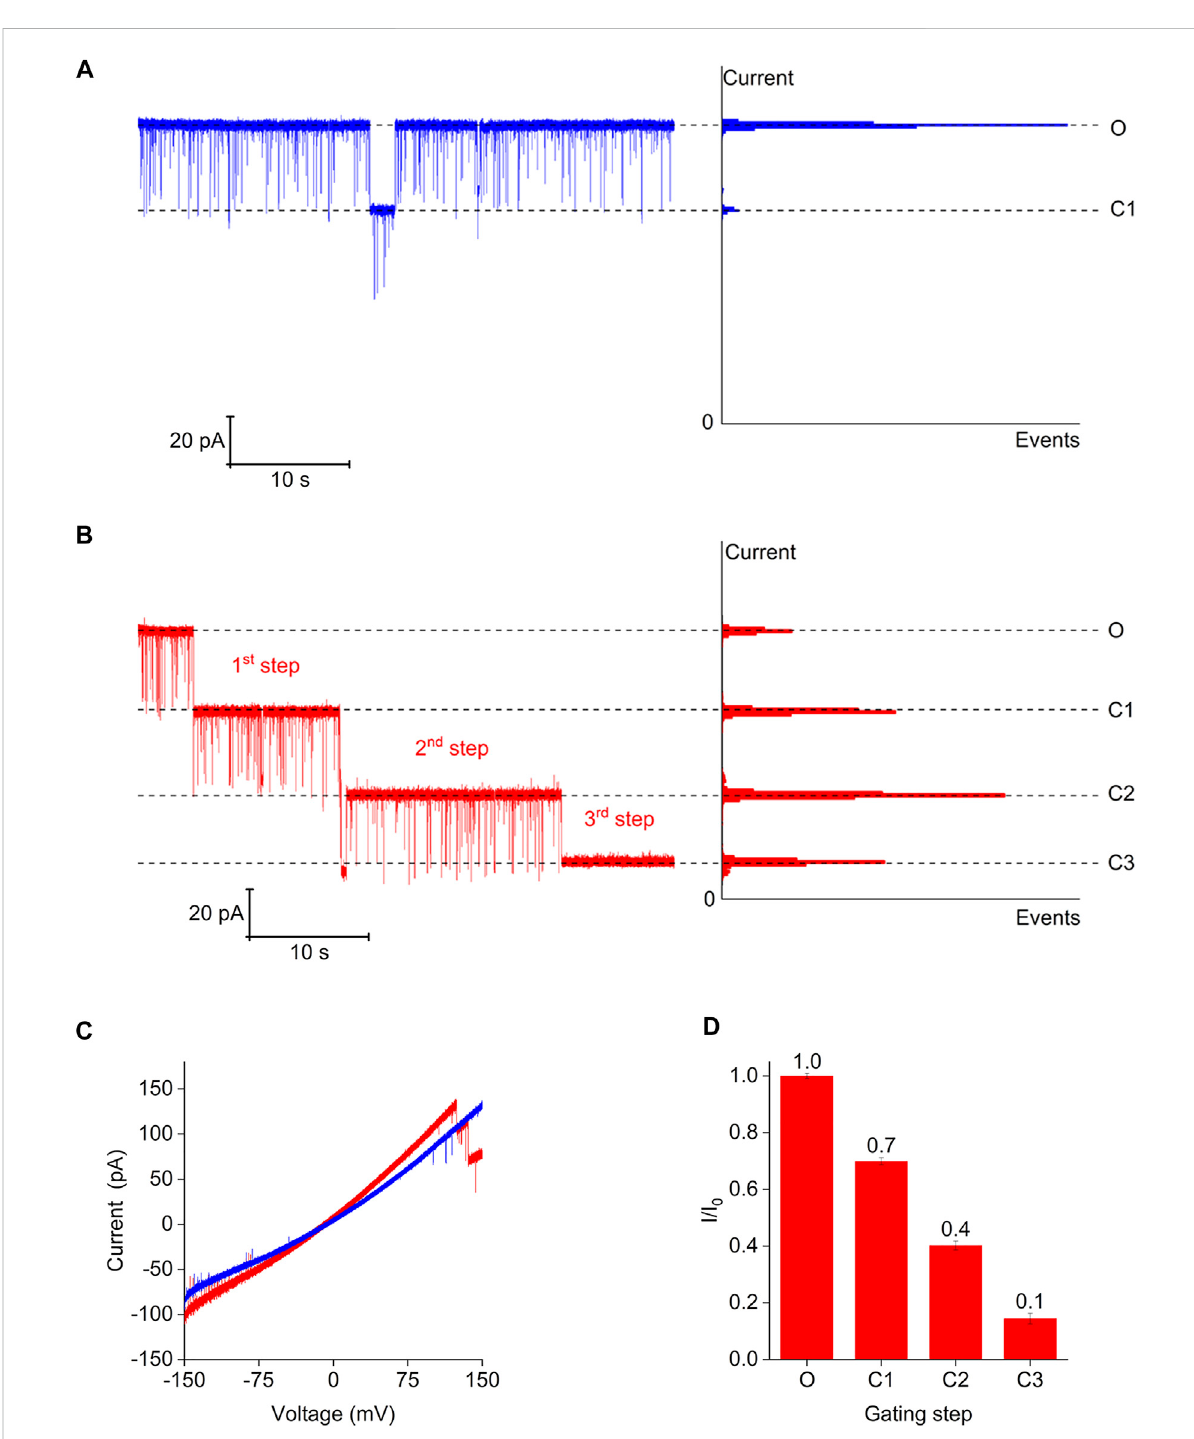
FIGURE 6 Step-wisegating ofBpss1228channeltriggered byMg 2+ . (A) RepresentativecurrenttracesoftheCorAchannelat150 mVinsymmetry150 mM NaCl solution, all chamber buffered with 10 mM HEPES, pH 7.5. All-points amplitude histogram generated from the continuous single-channel recording. (B) Representative step-wise current traces of the CorA channel in symmetry 150 mM NaCl solution, but the trans-chamber added in 10 mM MgCl 2 , and all chamber buffered with 10 mM HEPES, pH 7.5. All-points amplitude histogram generated from the continuous single- channel recording of. “ O, ” “ C1, ” “ C2, ” and “ C3 ” indicate open state and step-wise state of the CorA channel. (C) High ramping potential in different buffer conditions, and blue line represents (A) , red line represents (B) . (D) Histogram show the number and size of gating step. (Mean ± SE, n =